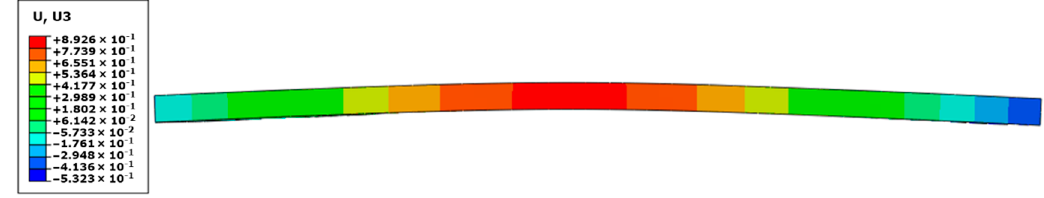
Figure 16. The deformation diagram of strap sheet with 0 gap. (Unit: mm). Table 3. Maximum deformation of strap sheets under different